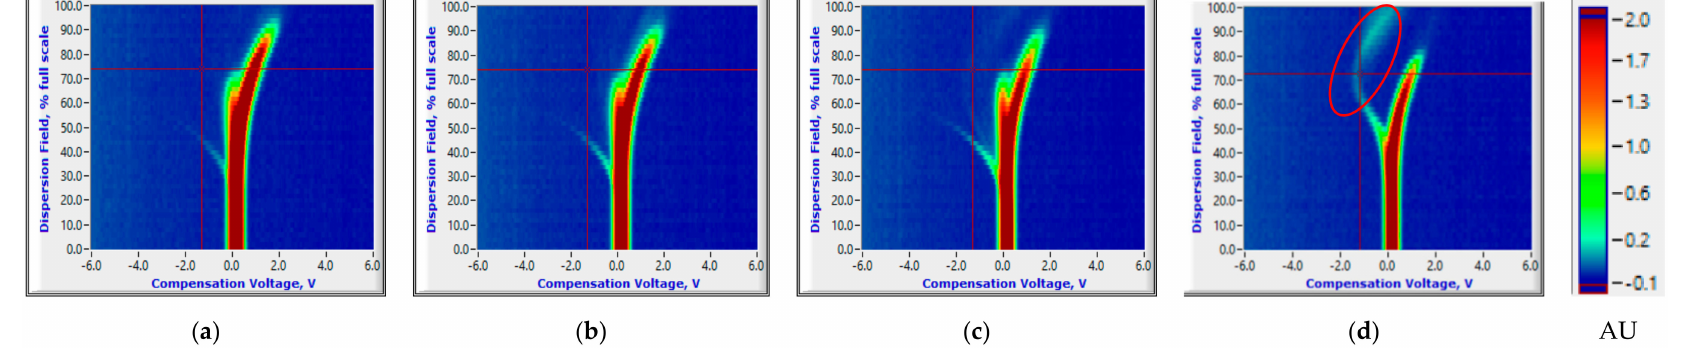
Figure 5. Ion current (AU) plots (corresponds to the color scale) at 0th (healthy control ( a ) and P. ultimum inoculated ( b )) and 14th (healthy control ( c ) and P. ultimum inoculated ( d )) days after inoculation for the Russet Burbank tuber sample replicates stored at room temperature (25 ◦